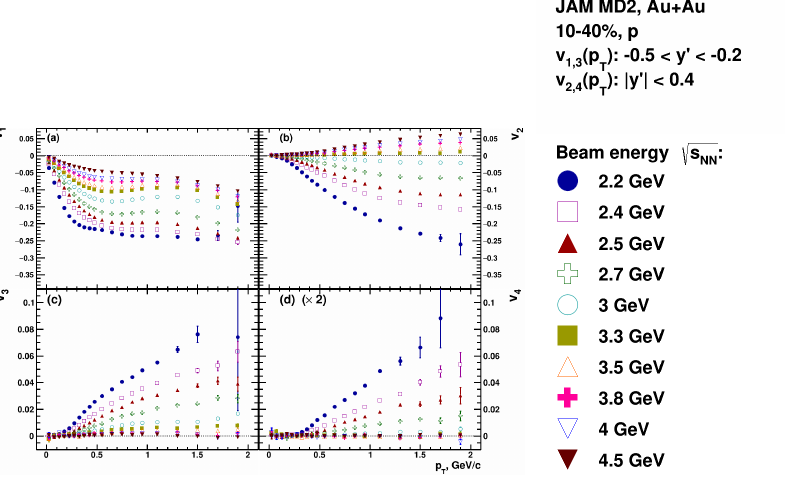
Figure 14. p T dependence of anisotropic flow coefficients v 1 , v 2 , v 3 and v 4 of protons ( a – d ) in the √ s NN = 2.2–4.5 GeV. Different symbols correspond to the 10–40% central Au + Au collisions at √ v n ( p T ) results obtained for different beam energies from s NN = 2.2 GeV (blue closed circles) to √ s NN = 4.5 GeV (brown down-pointing triangles) using the JAM model with hard momentum dependent mean-field MD2 ( K 0 = 380 MeV)